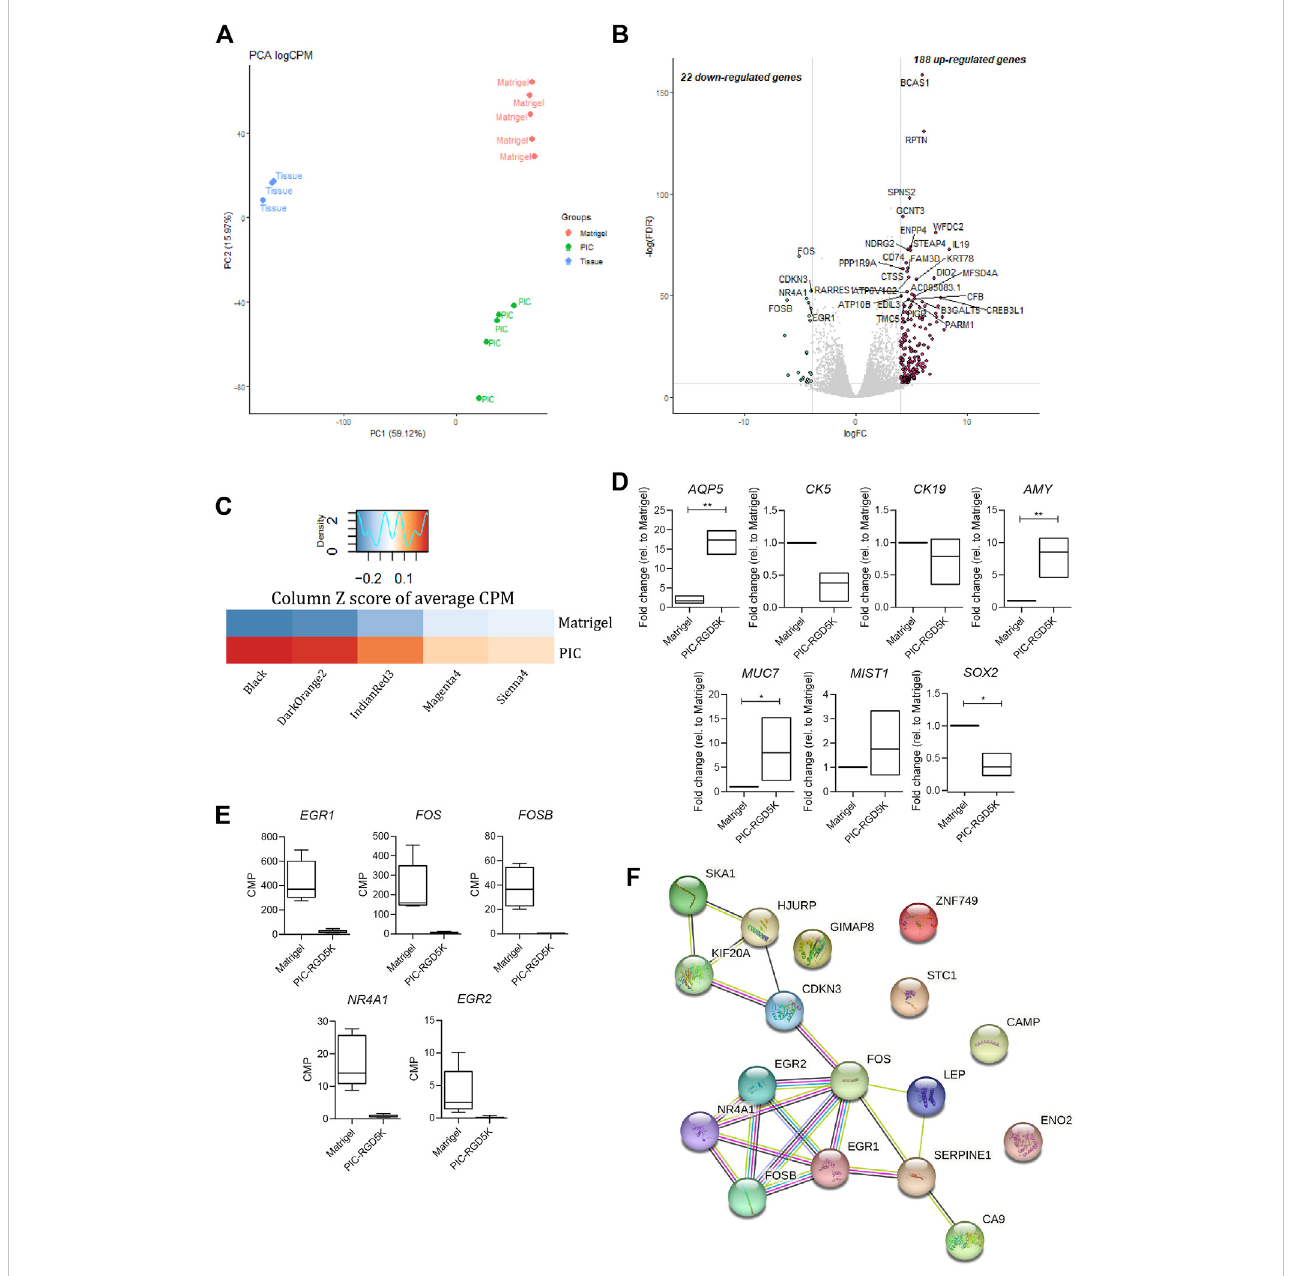
FIGURE 3 Polyisocyanopeptide (PIC)-cultured salivary gland organoids (SGOs)show reduced expression ofimmediateearlygenesandare inamore differentiated state than Matrigel-cultured SGOs (A) PCA plot of tissue, PIC- and Matrigel-cultured SGOs (B) Volcano plot depicting differentially expressed genes between PIC- and Matrigel-cultured organoids ( − 4 > logFC > 4, FDR < 0.001). Red and green dots represent signi fi cantly up- and downregulated genes in PIC-cultured SGO, respectively (C) Average counts per million (CPM) of genes (Supplementary Table S1) belonging to gene modules (Supplementary Table S2) associated with stem cell-like ( “ Sienna4, ” “ Magenta3, ” and “ IndianRed3 ” ) or differentiated ( “ Black ” and “ DarkOrange2 ” ) trait identi fi ed in unpublished data in PIC- and Matrigel-cultured SGO depicted as column Z score (D) Expression of differentiation markers AQP5, AMY, MUC7, MIST1, stem cell marker SOX2 and ductal markers KRT5 and KRT19 in PIC- and Matrigel-cultured SGOs from three patients ( n = 3). Multiple t-test was used to test the differences between the groups. * p < 0.05, ** p < 0.01, *** p < 0.001 (E) Gene expression (CPM) of immediate early genes in Matrigel- and PIC-cultured SGO ( n = 5) (F) STRING (Search Tool for the Retrieval of Interacting Genes/Proteins) analysis of the 22 downregulated genes in PIC- compared to Matrigel-cultured